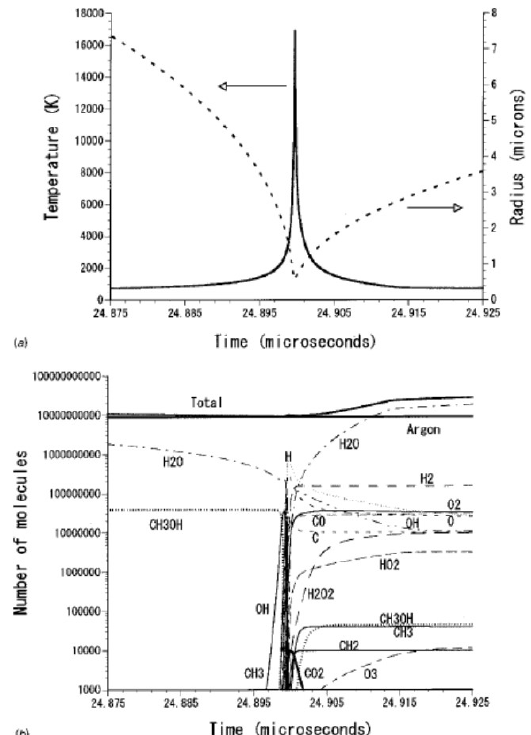
Figure 5. The calculated results at around the minimum bubble radius for aqueous methanol solution [27]. The condition is the same as that of Figure 3. ( a ) The bubble radius and the temperature inside a bubble. ( b ) The numbers of molecules inside a bubble with logarithmic vertical axis. Copyright 2002, with the permission of AIP Publishing.